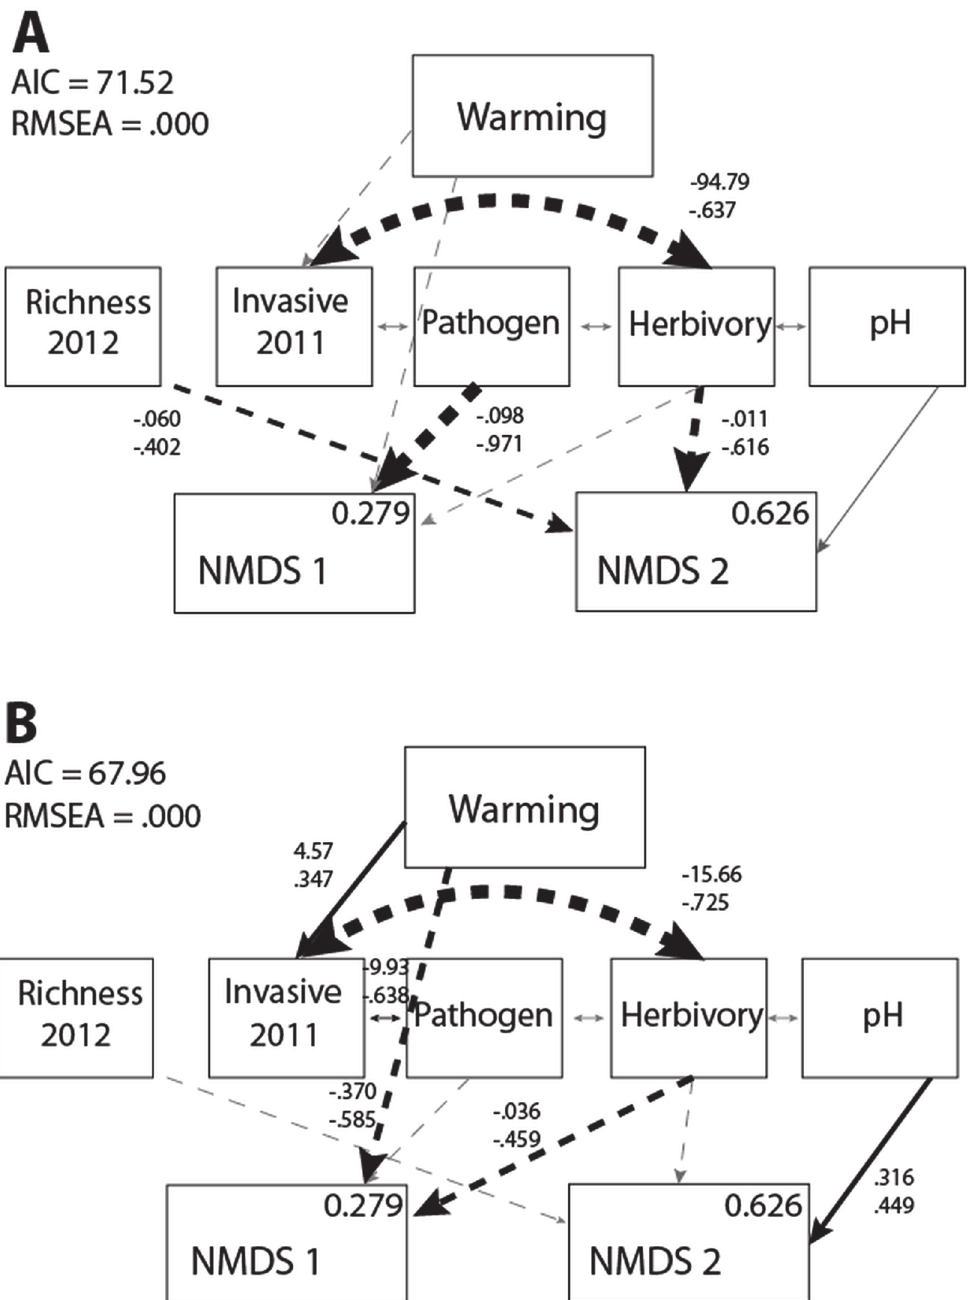
Fig 2. Results of the warming SEM. Warming effects on plant community NMDS scores in the (A) absence ( χ ² = 15.519, d.f. = 16, p = 0.487) and (B) presence of invasion ( χ ² = 10.002, d.f. = 16, p = 0.867). Arrow characteristics and all values as in Fig 1.